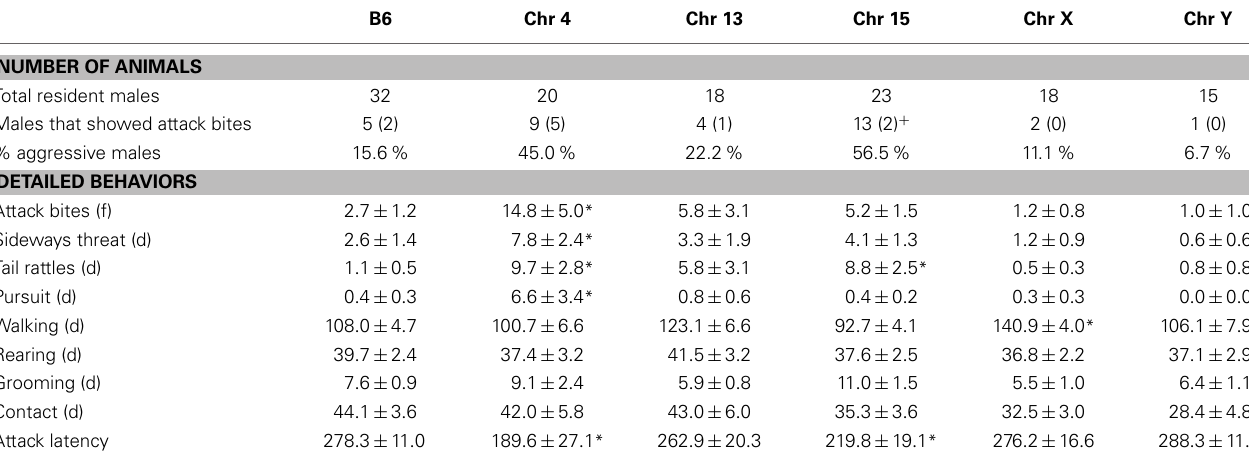
Table 3 | Resident-intruder test in five consomic mouse strains and B6.